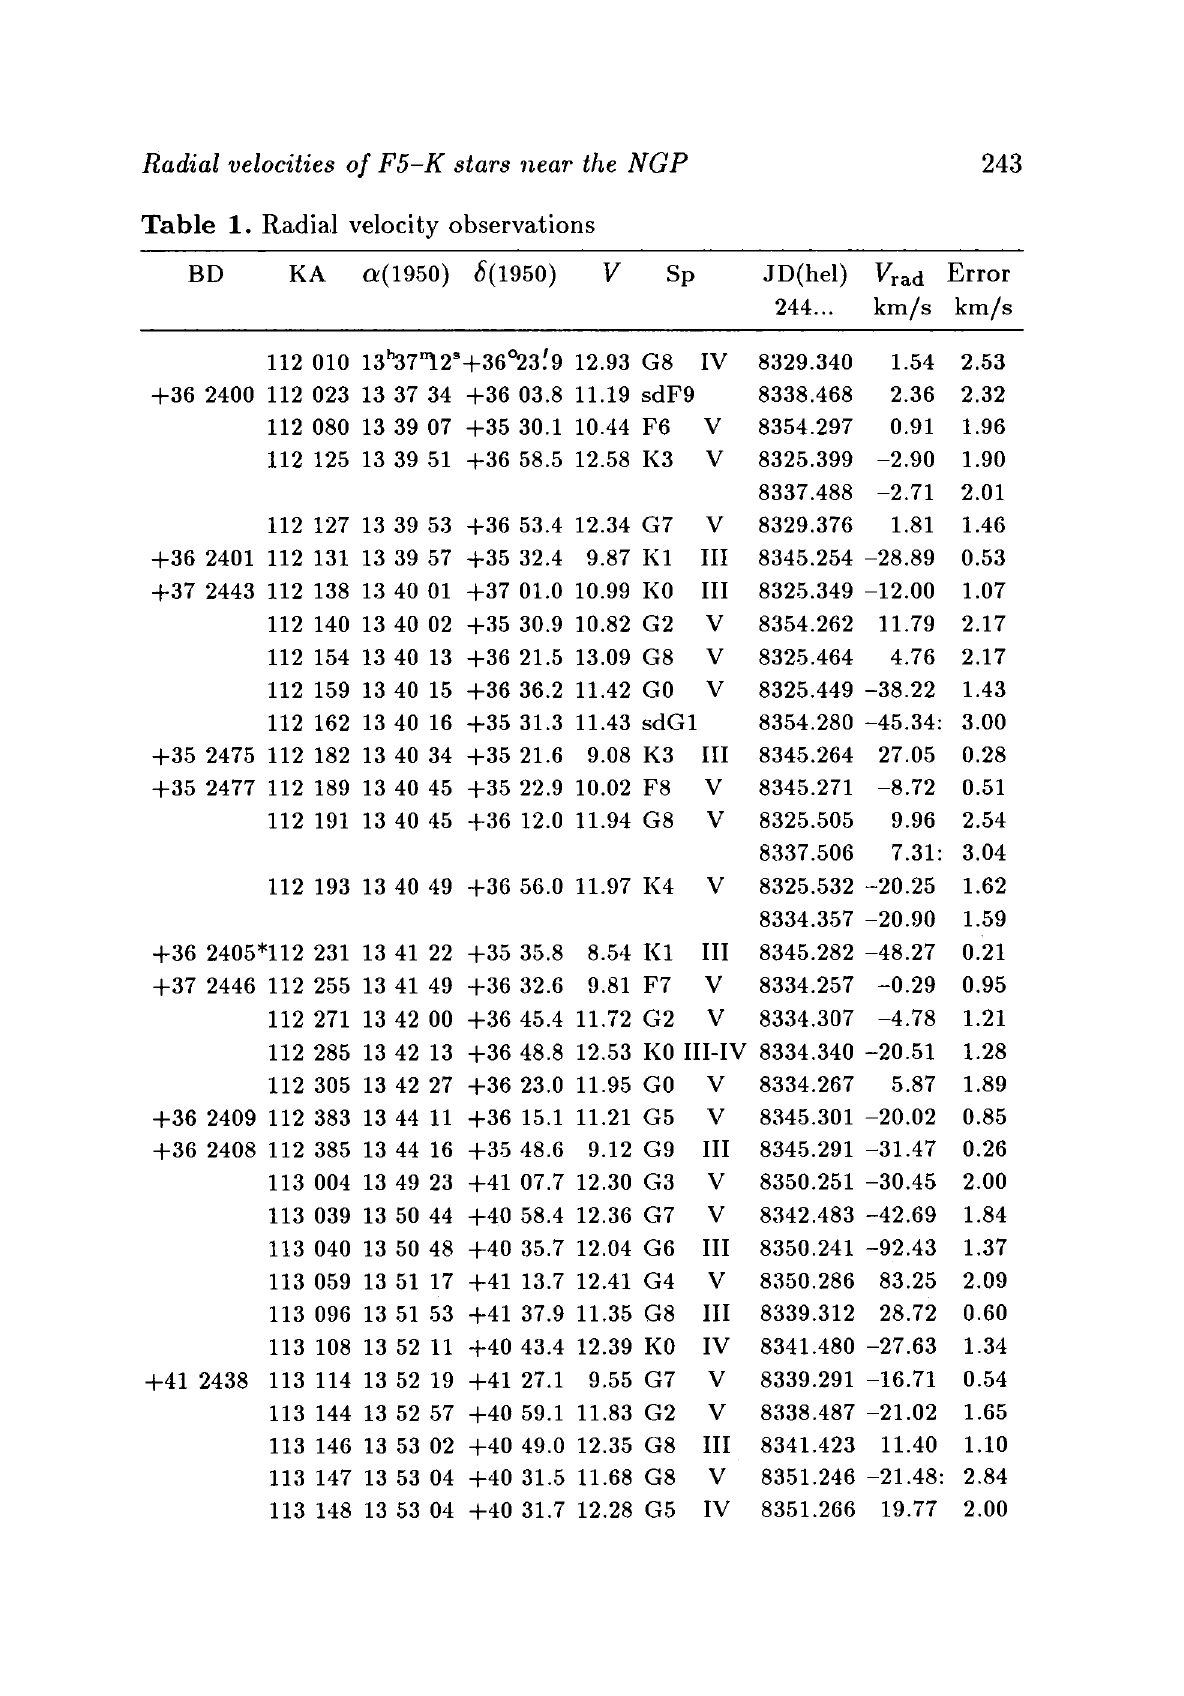
Table 1. Radial velocity